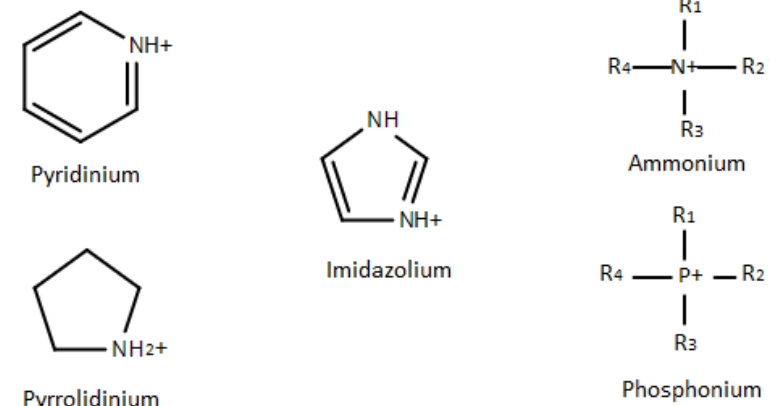
Figure 4. Common cations used for synthesizing ionic liquids. Table 2. Different types of anions existing in ionic liquids [89,90].